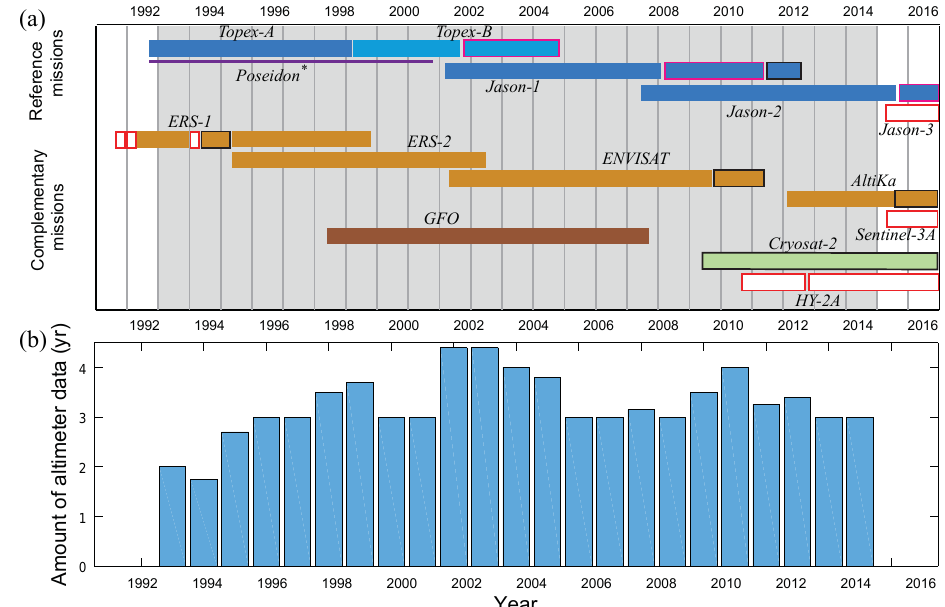
Figure 1. (a) Gantt chart of the available altimetry missions. (Full names of satellites and other commonly used abbreviations are given in Appendix A.) ∗ The spacecraft TOPEX/Poseidon had two separate altimeters, with the experimental Poseidon instrument on for ∼ 10% of the time, during which TOPEX did not operate. The “reference missions” all commenced in the same orbit, with 66 ◦ orbit inclination and a repeat period of 9.92 days; subsequent phases of those missions were then in a 9.92-day interleaved orbit (pink outline) or a long-repeat (geodetic) orbit (black outline). The missions highlighted in orange were principally in another common orbit (98.5 ◦ inclination and 35-day repeat), except for geodetic phases (black outline) and short periods in a 3-day repeat (ERS-1). The other complementary missions are GFO (72 ◦ inclination, 17.05-day) and CryoSat-2 (88 ◦ inclination, geodetic orbit). The periods indicated by white bars with red outlines are not used in the production of CCI v2.0 product. (b) Annual amount of independent altimeter data used in the production of the v2.0 dataset. (Note, for example, that during the 6-month “tandem” phases between successive “reference missions” the contribution of one of the pair to the sea level record is